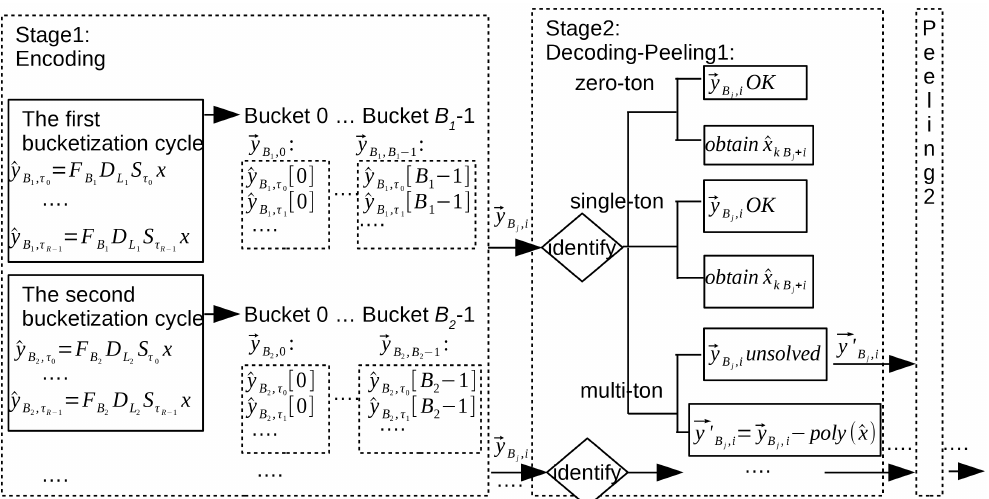
Figure 2. A system block diagram of the peeling